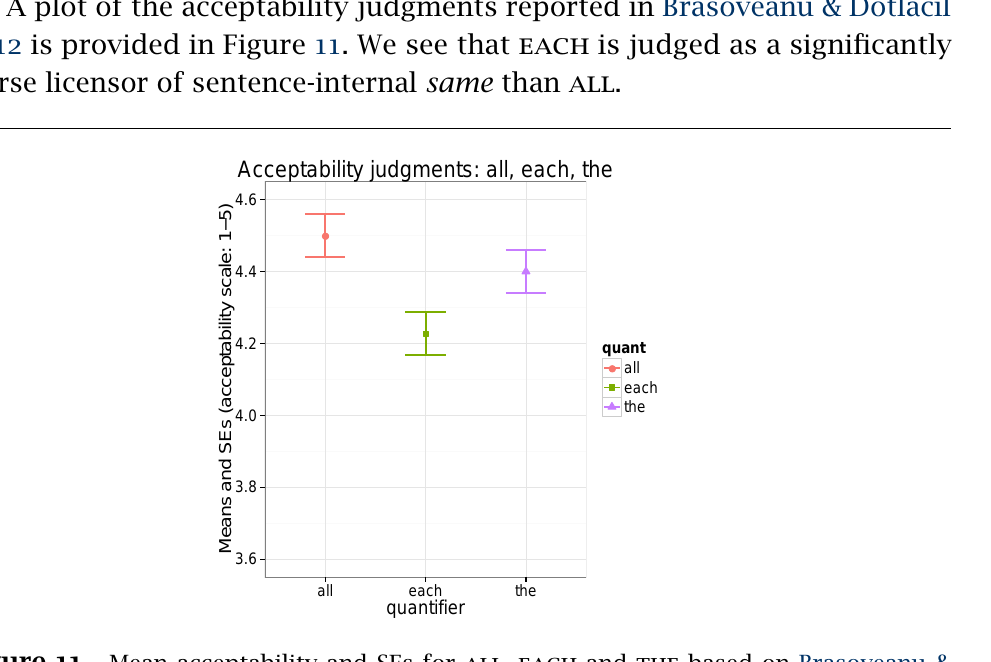
Figure 11 Mean acceptability and SEs for all , each and the based on Brasoveanu & Dotlaˇcil 2012 (acceptability scale: 1 (worst), 2 , 3 , 4 , 5